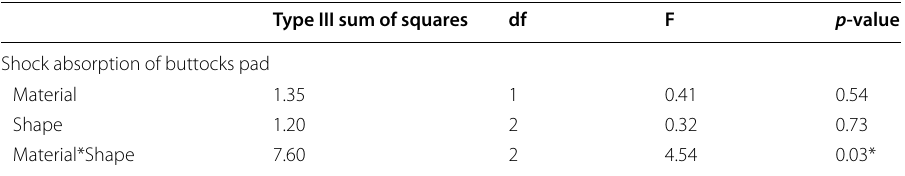
Table 8 Shock absorption of buttocks pad depending on material and shape (repeated measures ANOVA)